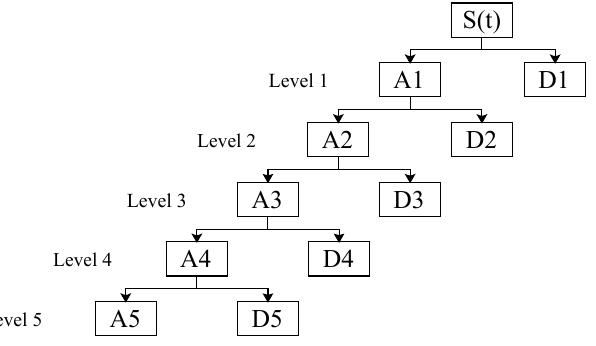
Figure 2. Decomposition wavelet in five levels: tree